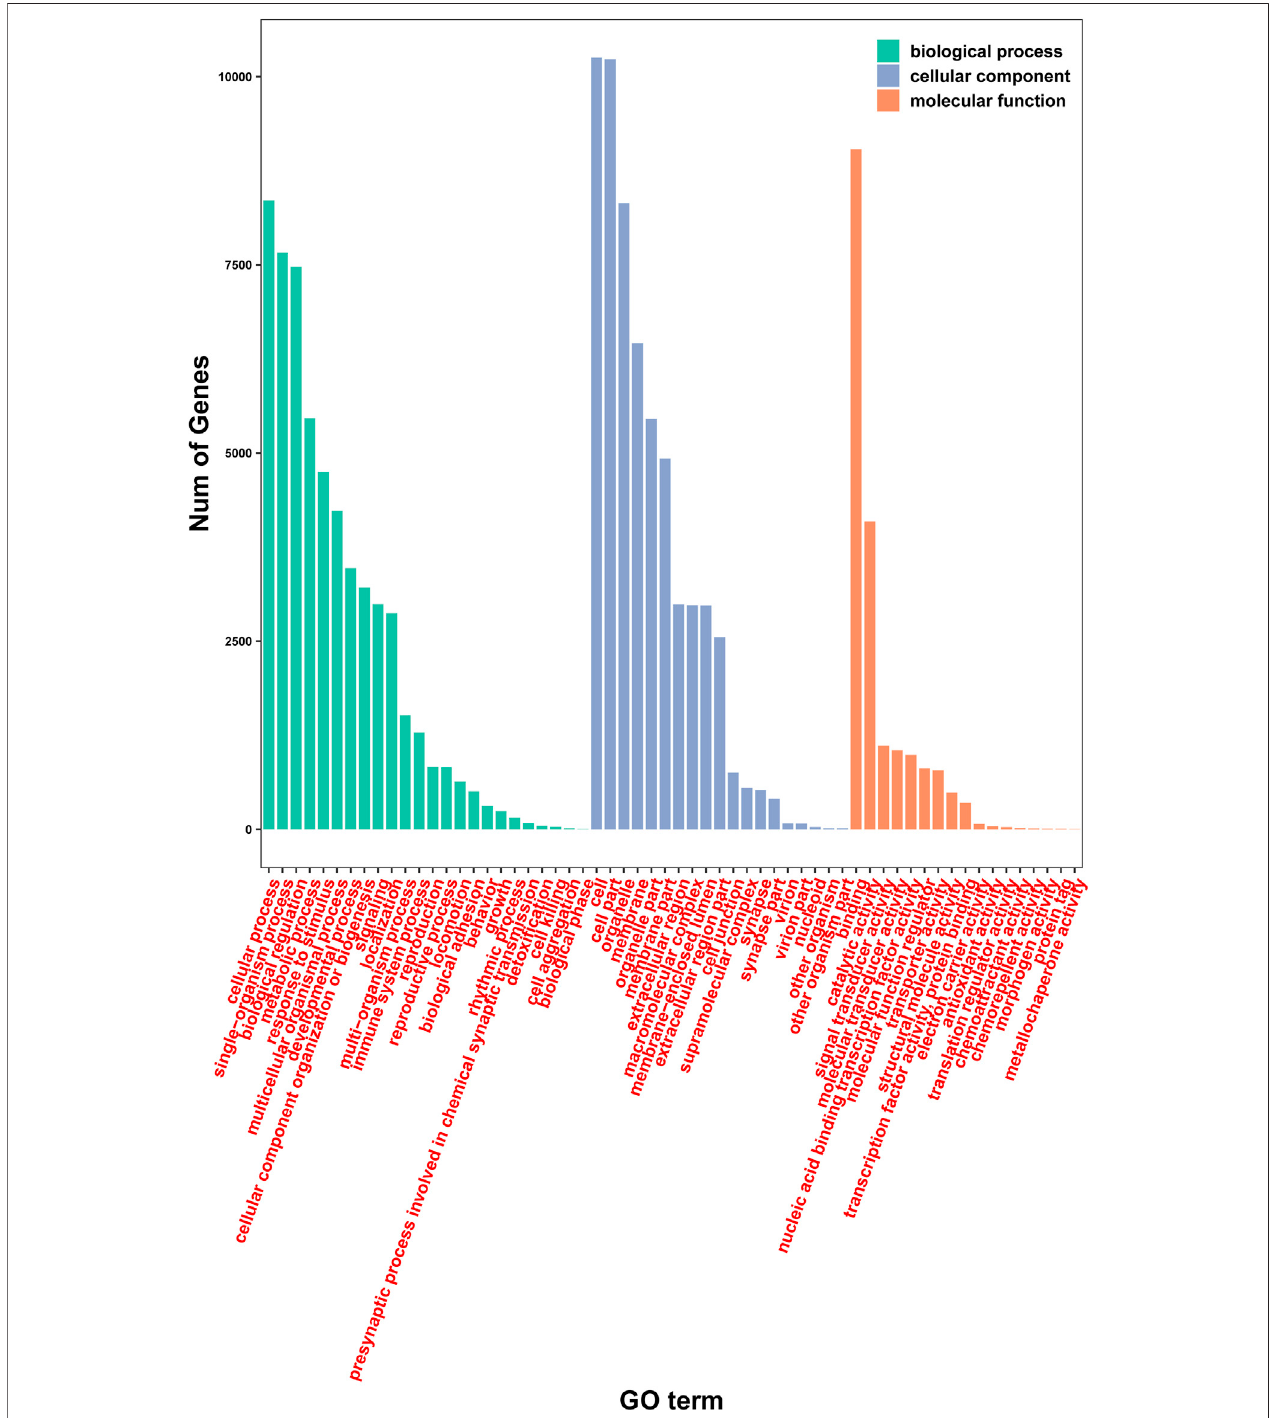
FIGURE 5 | Analysis of gene function using the GO database.